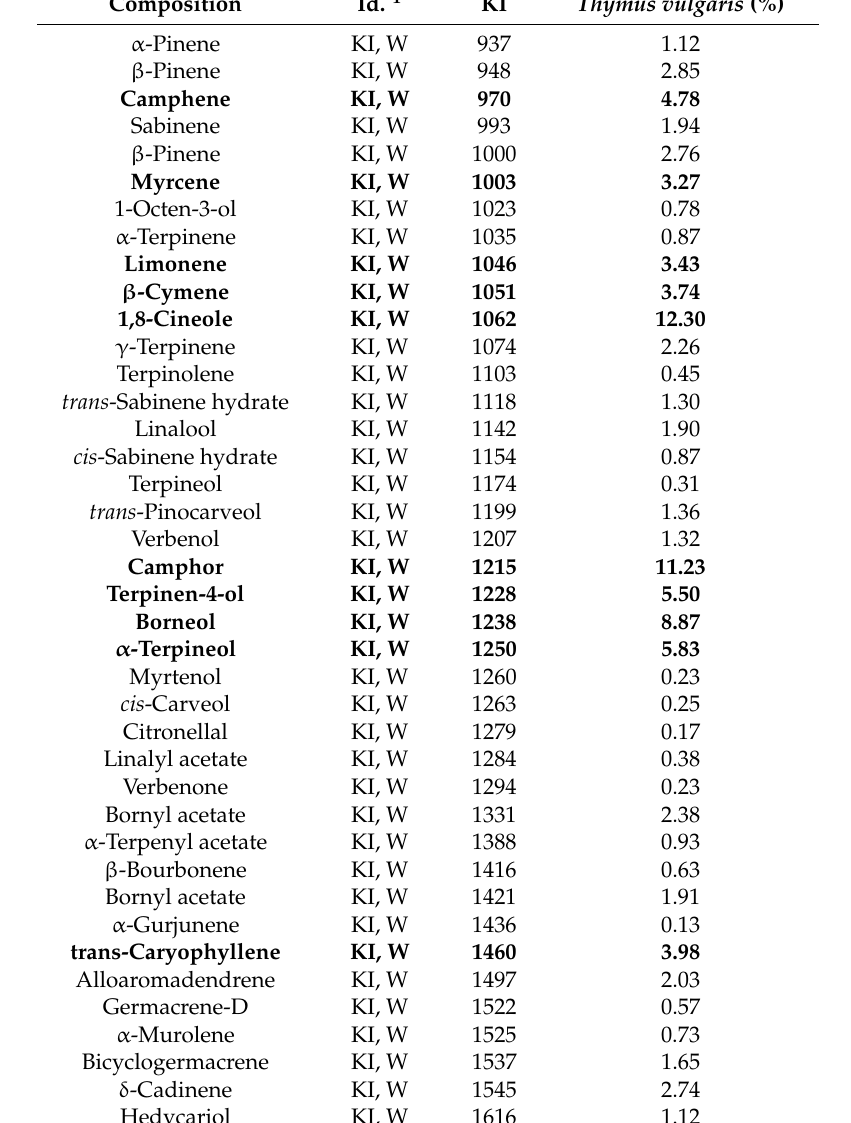
Table 1. Principal constituents of Thymus vulgaris essential oil, their relative percentages of the total chromatogram area, and Kovats